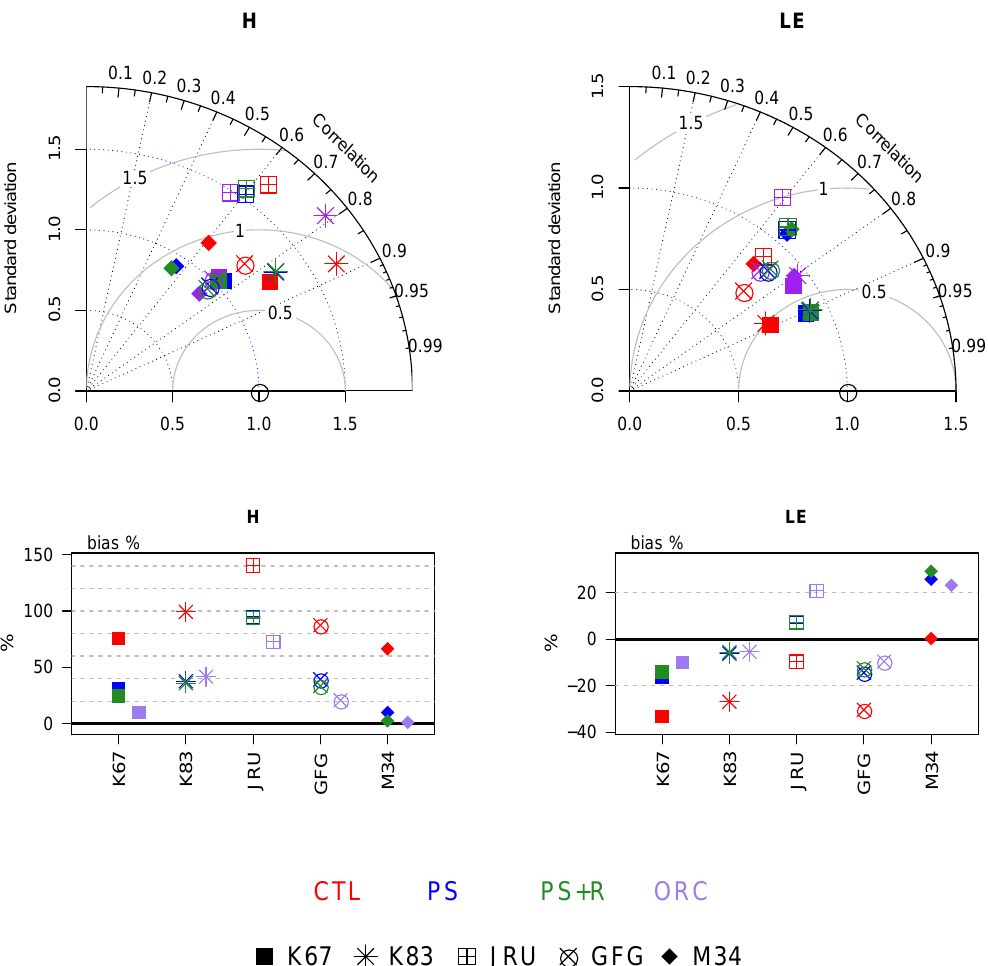
Figure 5. Taylor diagrams (top) and bias (%) (bottom) calculated among hourly values removing night values (short-wave down ≤ 5Wm − 2 ) for H and LE at the five flux towers and for each available period (see Table 1). In the Taylor diagrams, correlation extends radially from the origin. The blue lines indicate identical ratios of standard deviation of the simulated flux to the observed flux. The gray lines represent identical root mean square errors (RMSE) of the centered